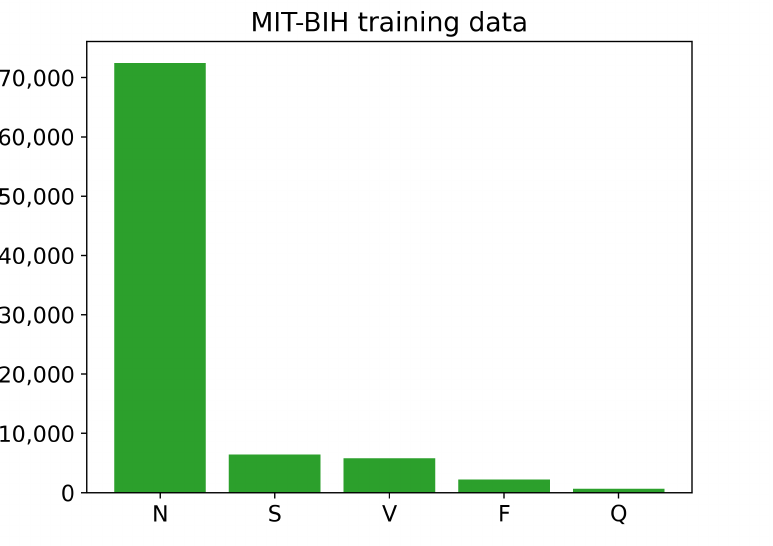
Figure 6. The number of images of each class in training PhysioNet MIT-BIH Arrhythmia